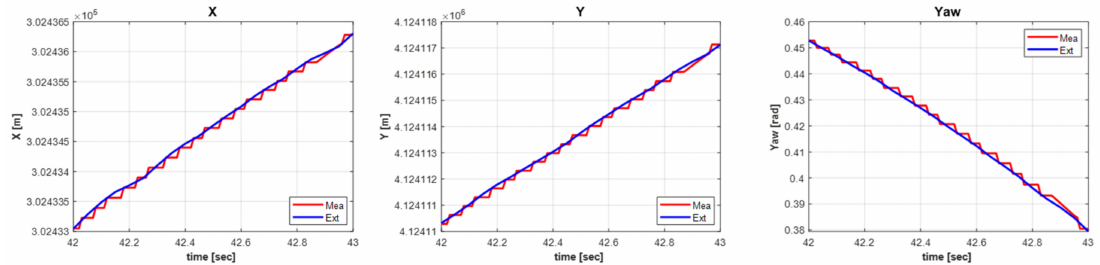
Figure 5. Result of extrapolation process.